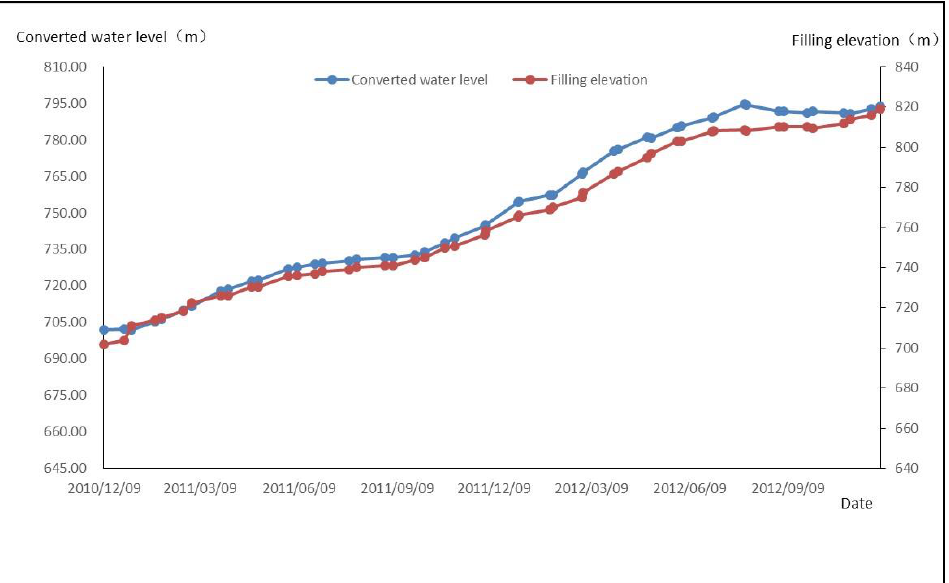
Figure 6. Osmotic Pressure and Filling Elevation Timing Process Diagram.